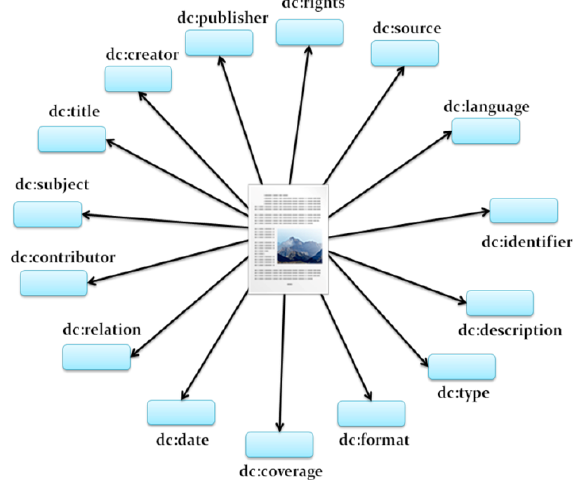
Figure 3. Dublin Core